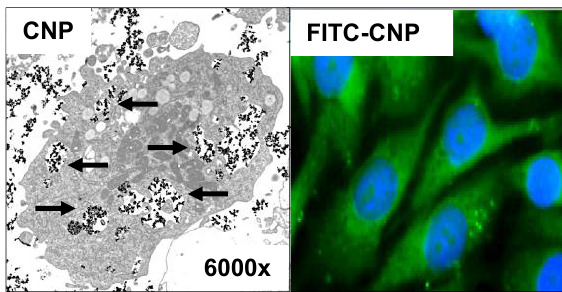
Figure 1. Cellular uptake of cerium oxide nanoparticles (CNP) Squamous tumor cells of the skin were treated with 150 µM CNP or fluorescein isothiocyanate (FITC)-labeled CNP for 24 h. Data of studies with trans electron microscopy ( left ) indicate uptake of CNP (see arrows). Studies with FITC-CNP (green fluorescence) show distribution of CNP in the cytosol, while there appears no green fluorescence (or merged cyan fluorescence) of the nuclei (blue, 4′,6 -Diamidin-2-phenylindol (DAPI)-staining). Hirst and coworker detected CNP around the mitochondria which subsequently scavenge mitochondria-generated ROS in normal murine macrophages [62]. Furthermore, nanoceria were